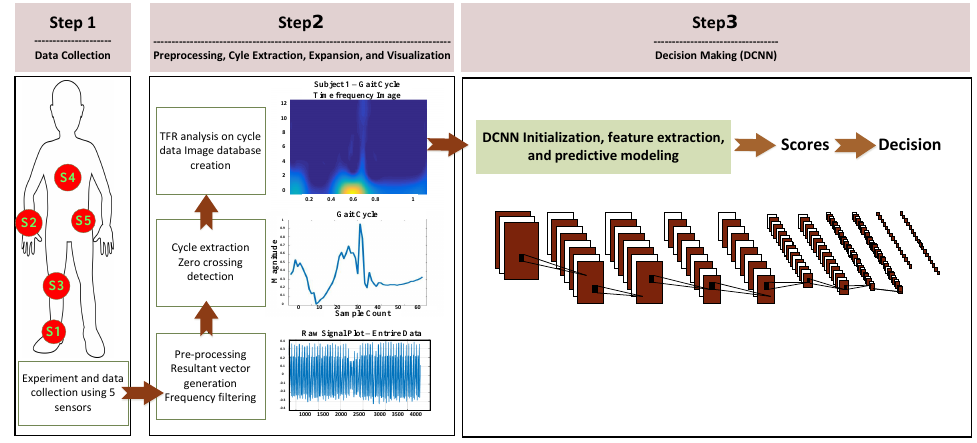
Figure 2. The overview of our proposed system for Human Gait